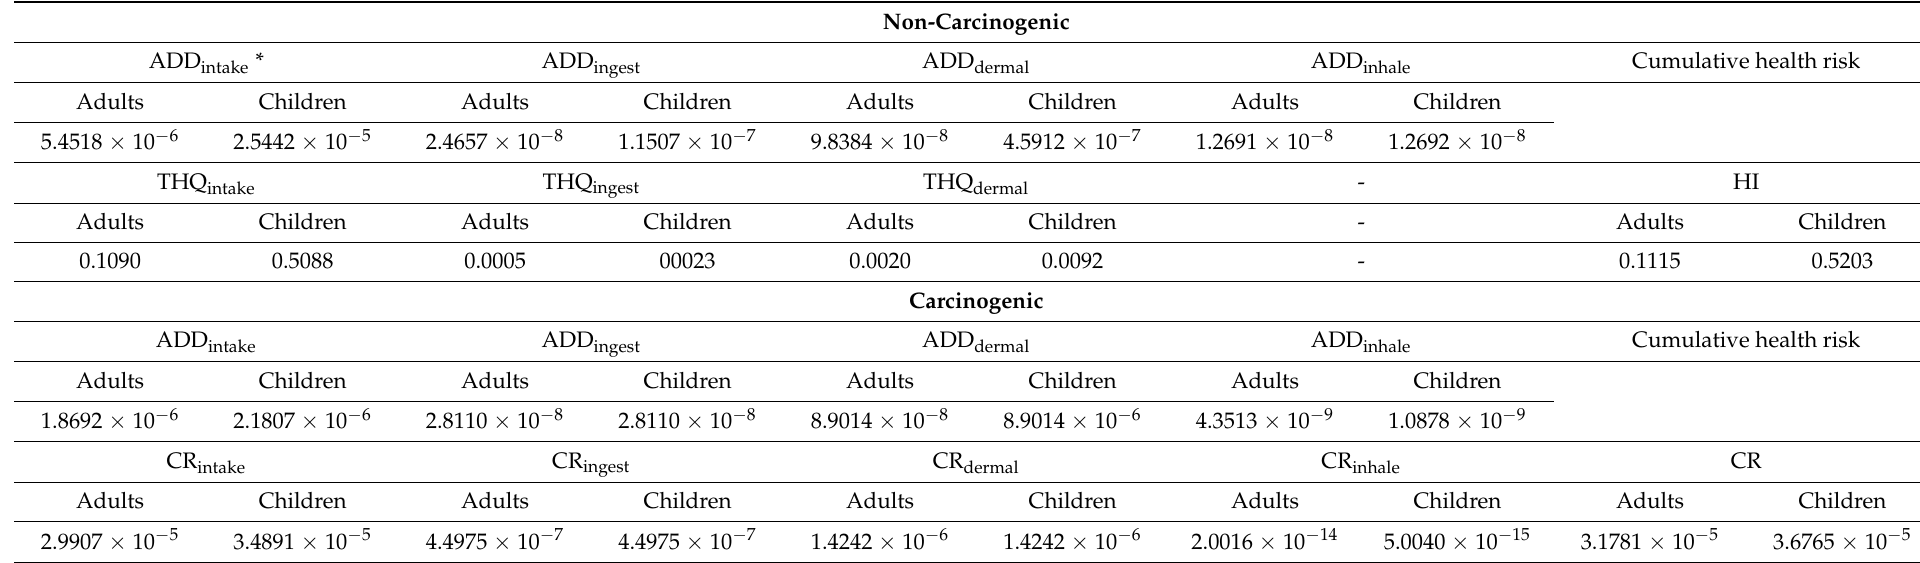
Table 2. Health risk assessment